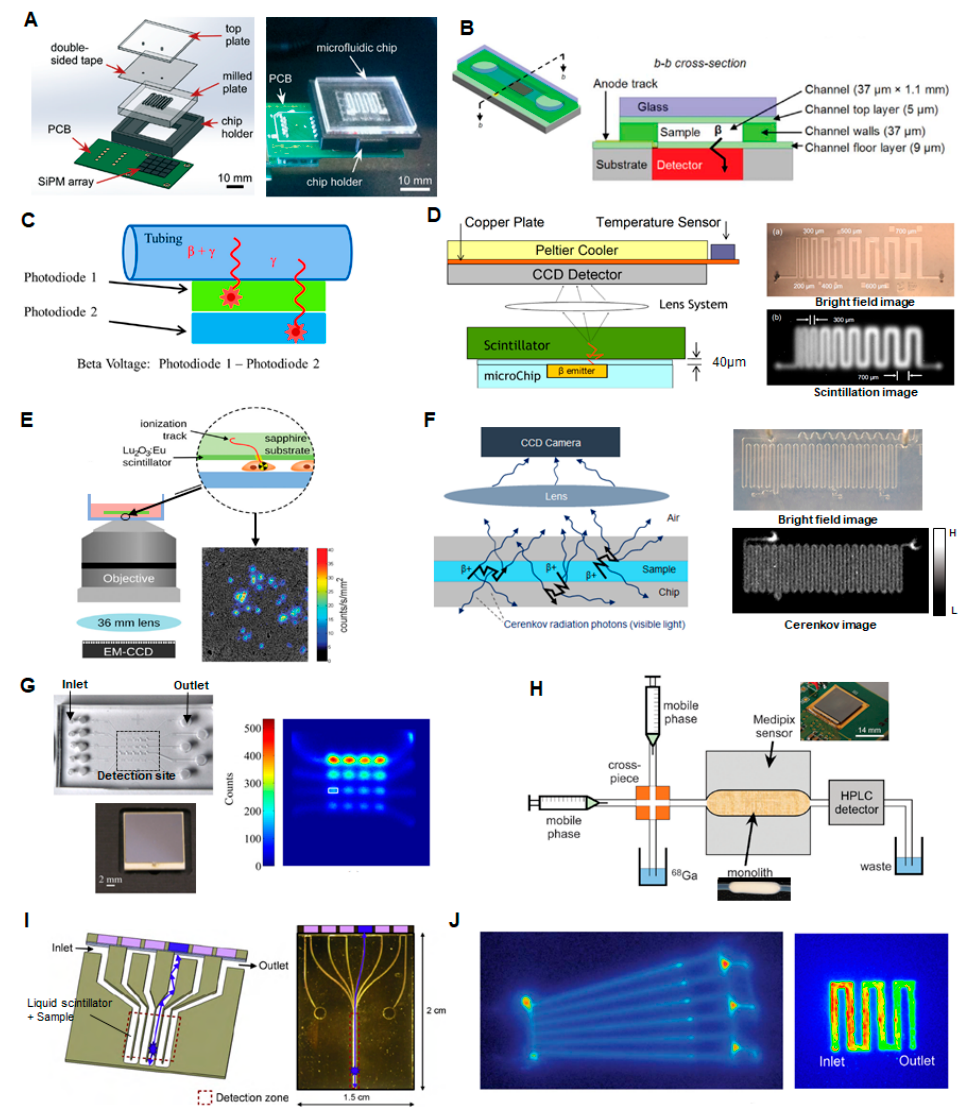
Figure 6. Examples of radiation detection methods ( A ) ( left ) Setup of microfluidic chip and silicon photomultiplier (SiPM) array for measurement of radioactivity and half-life of a sample. ( right )